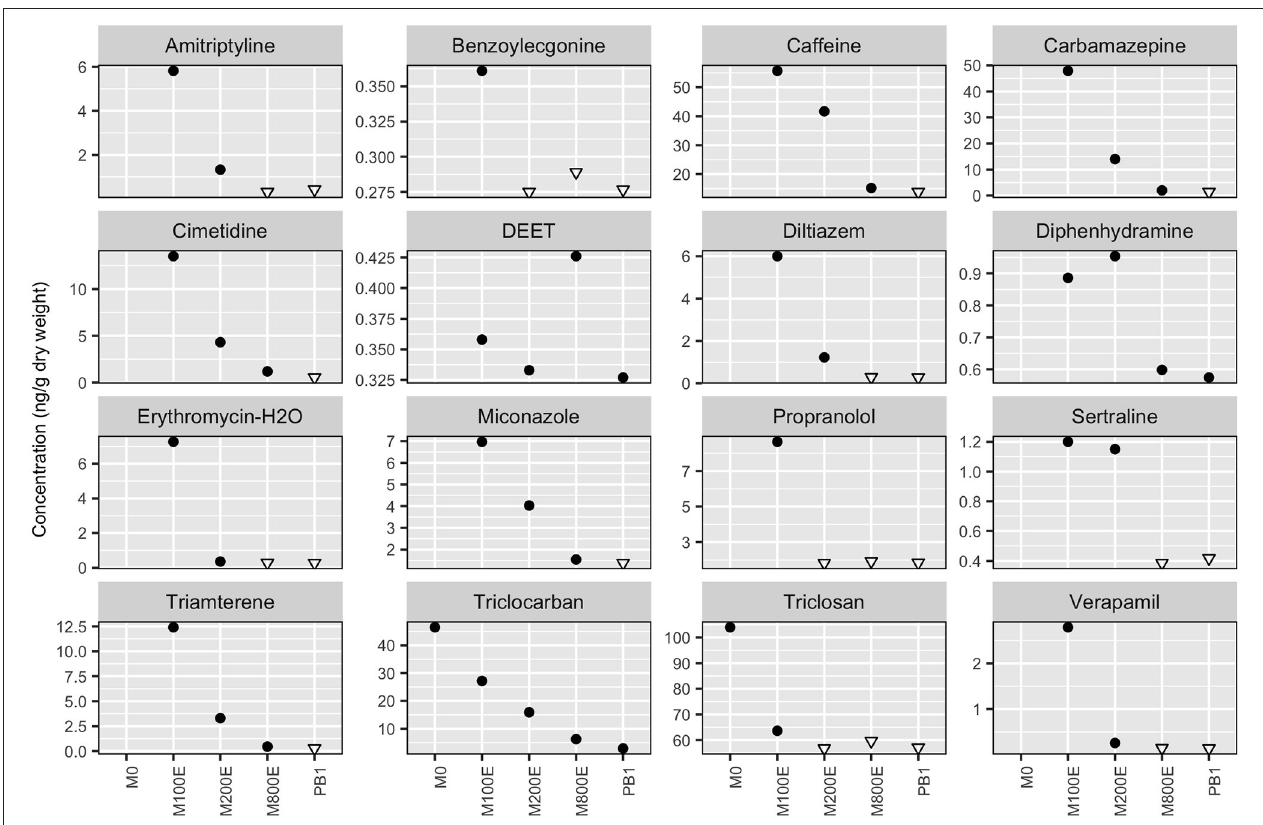
FIGURE 4 | Detection (marked with filled circles) of PPCP’s in the sediment surrounding the MAC outfall. Distance between the outfall and the station increase toward the right side of the plots. Only List 3 compounds were analyzed for at M0, from which only triclocarban and triclosan were detected. Open downward facing triangles indicate sample specific detection limits where no detection